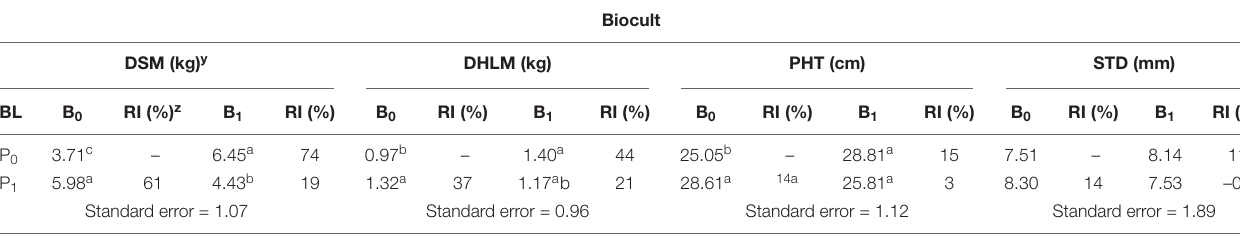
TABLE 1 | Relative impact (RI) of Biocult (B) and Nemafric-BL phytonematicide (P) on dry harvestable leaf mass (DHLM), dry shoot mass (DSM), plant height (PHT), and stem diameter (STD) of cowpea var. Eureka at 56 days after the treatments under field conditions ( n = 80). Biocult